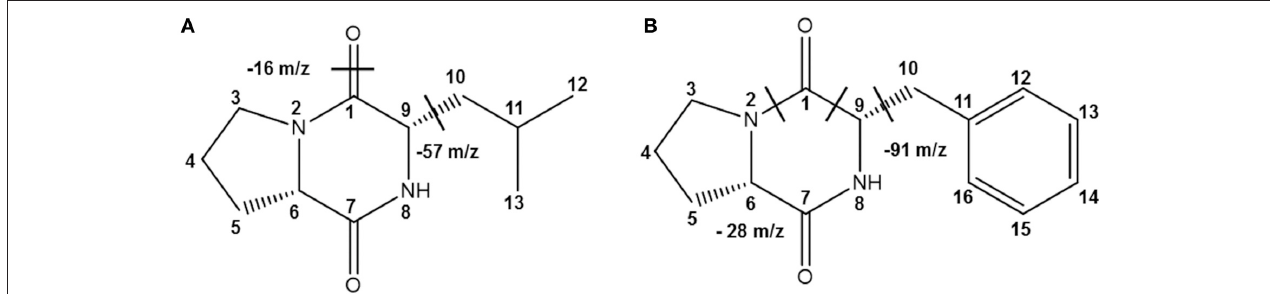
FIGURE 2 | The identified CDPs from fractions N113 and N15 from Ln. mesenteroides LBP-K06. EI fragmentation patterns are indicated. EI-values of N13 and N15 and their fragmentation patterns have been assigned to be the proline-based (A) cyclo(Leu-Pro) (C 11 H 18 N 2 O 2 ) and (B) cyclo(Phe-Pro) (C 14 H 16 N 2 O 2 ), respectively.